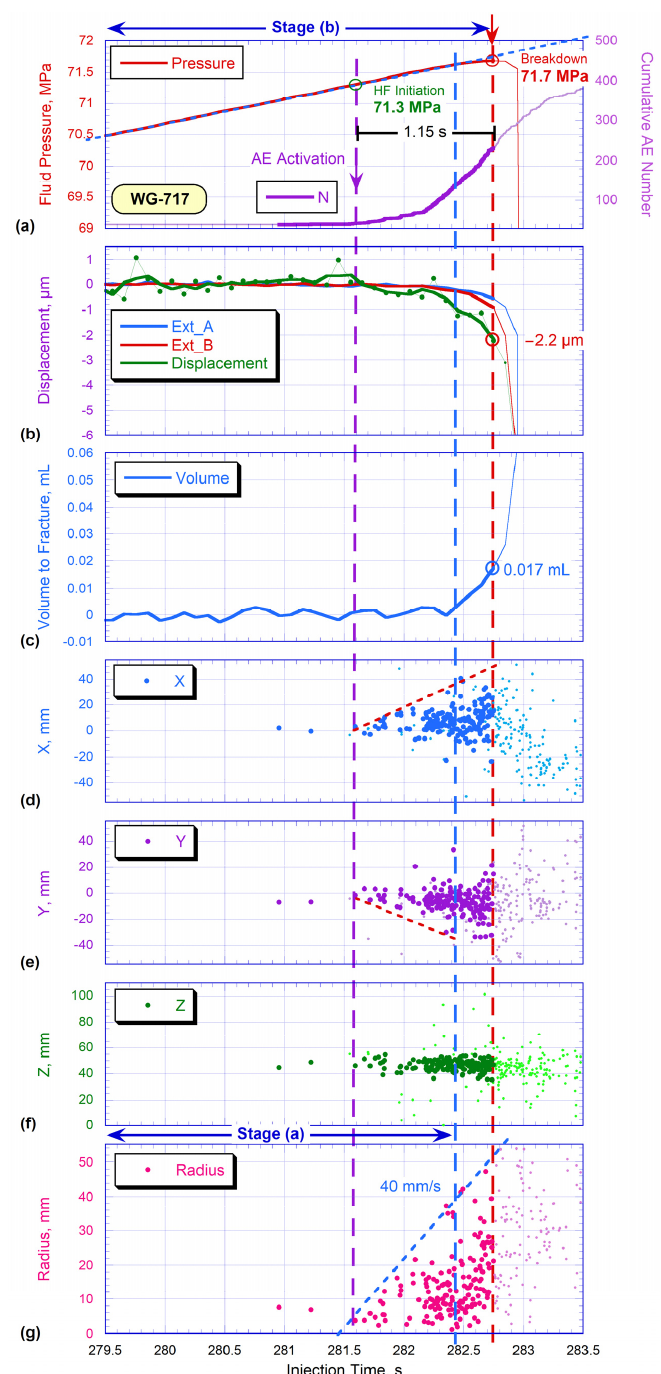
Figure 12. Sample WG-717: ( a ) fluid pressure (red) and the total number of AE signals located (purple); ( b ) axial deformation measured by the left (Ext_B, red) and right (Ext_A, blue) extensometers and a curve demonstrating loading piston position (green); ( c ) the volume of fluid injected into the hydraulic fracture; ( d , e ) horizontal coordinates of the located AE signals in the X and Y directions, respectively; ( f ) vertical coordinates of the located AE signals; ( g ) Distribution of the distances between located AE signals and the axis of the sample. All parameters are plotted versus the time of sample